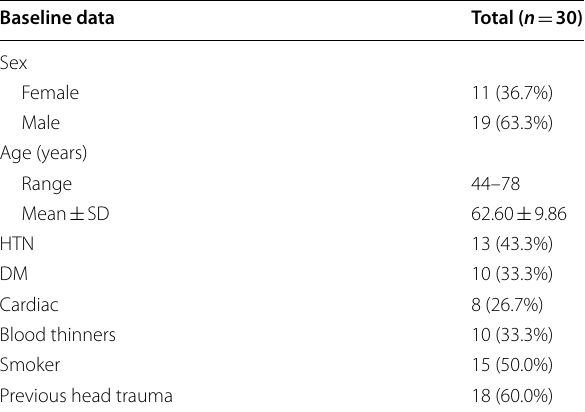
Table 1 Demographic data and risk factors of the studied patients